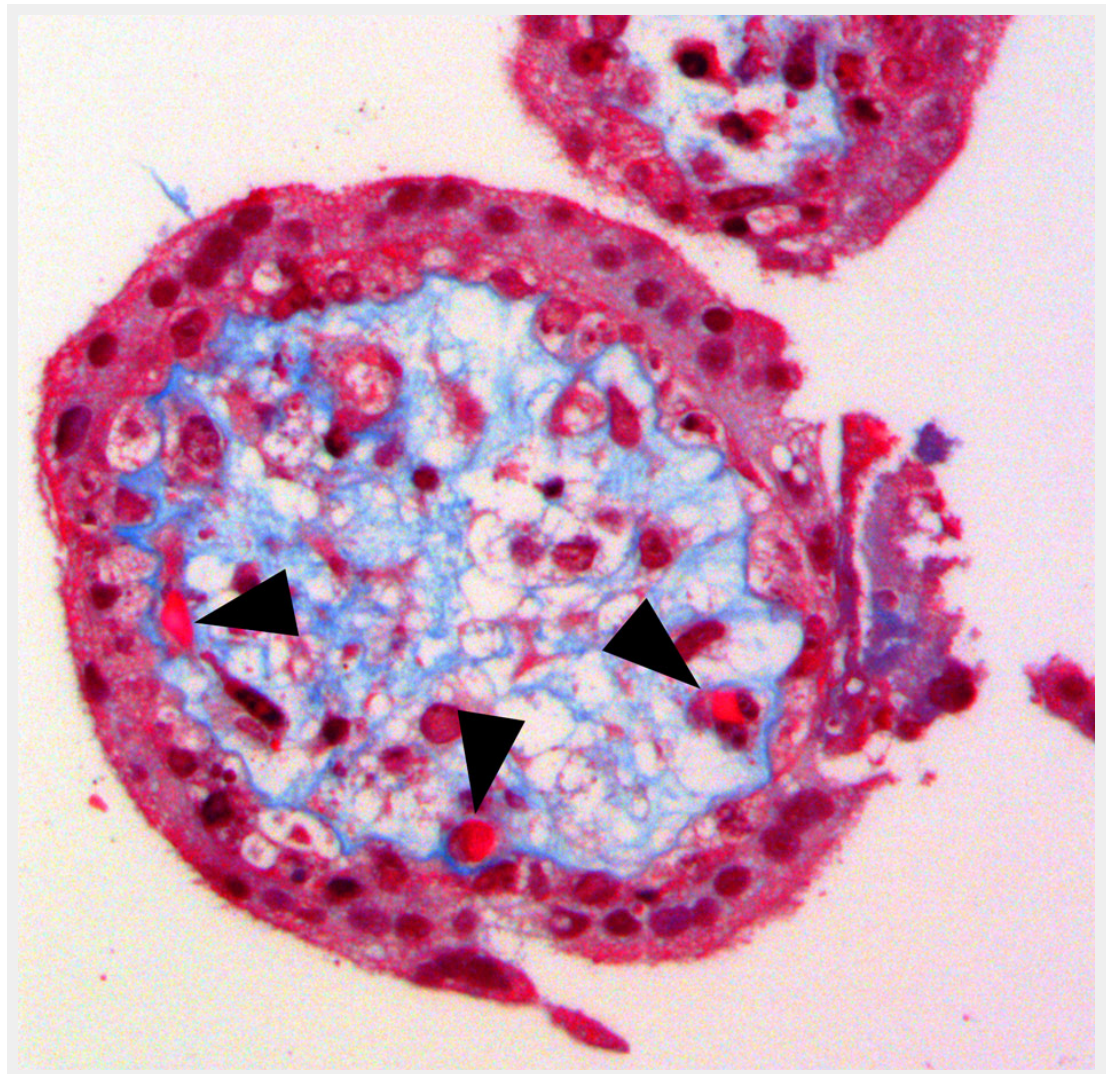
Figure 3 Histomorphology of a chorionic villus showing the outer trophoblastic coverage surrounding the inner foetal mesenchyme also comprising the foetal capillaries (black arrows). (Reprinted from: Weber B, Zeisberger SM, Hoerstrup SP. Prenatally harvested cells for cardiovascular tissue engineering: Fabrication of autologous implants prior to birth. Placenta. 2011;32(Suppl. 4):S316–9. © Elsevier, Oxford, UK, with kind